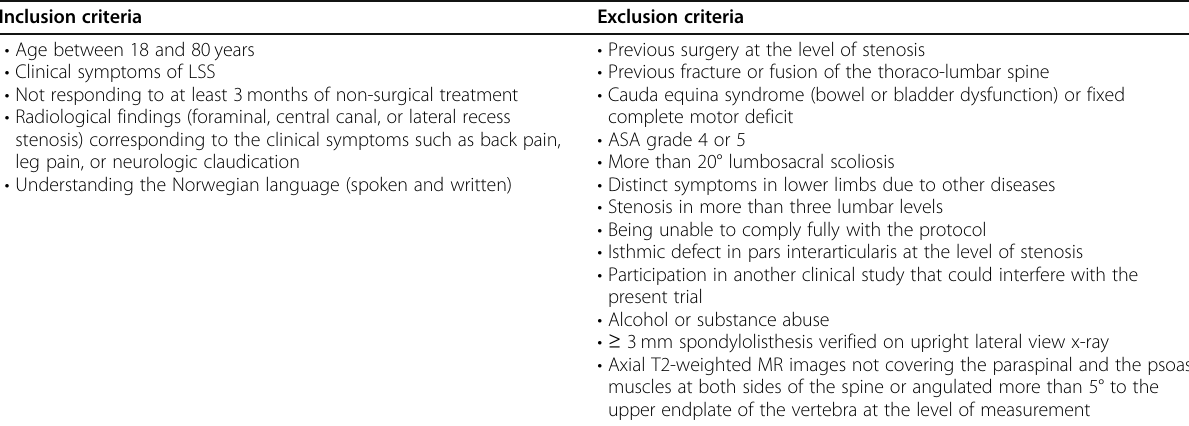
Table 1 Inclusion and exclusion criteria Inclusion criteria Exclusion criteria